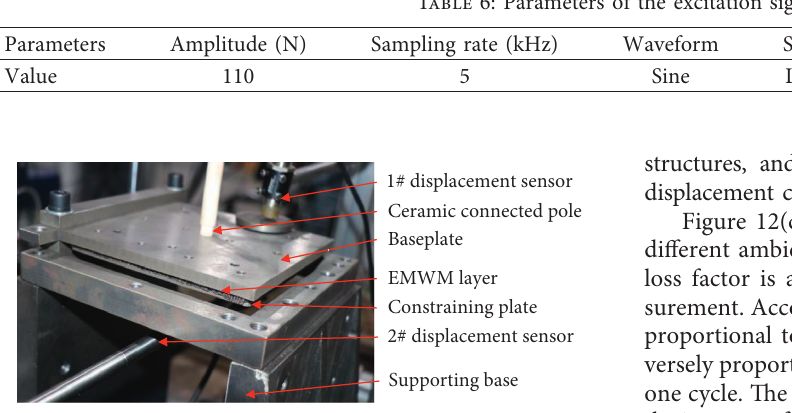
Figure 10: Displacement deviation test